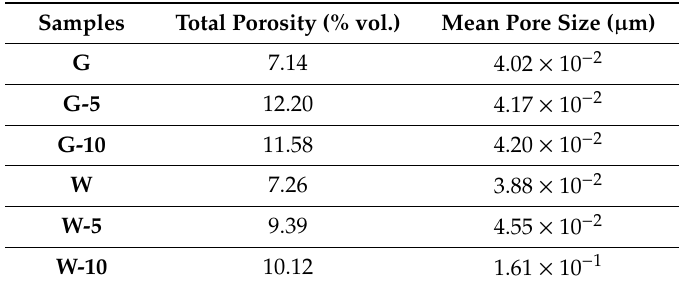
Table 4. Characteristics of the microstructure of the mortars.